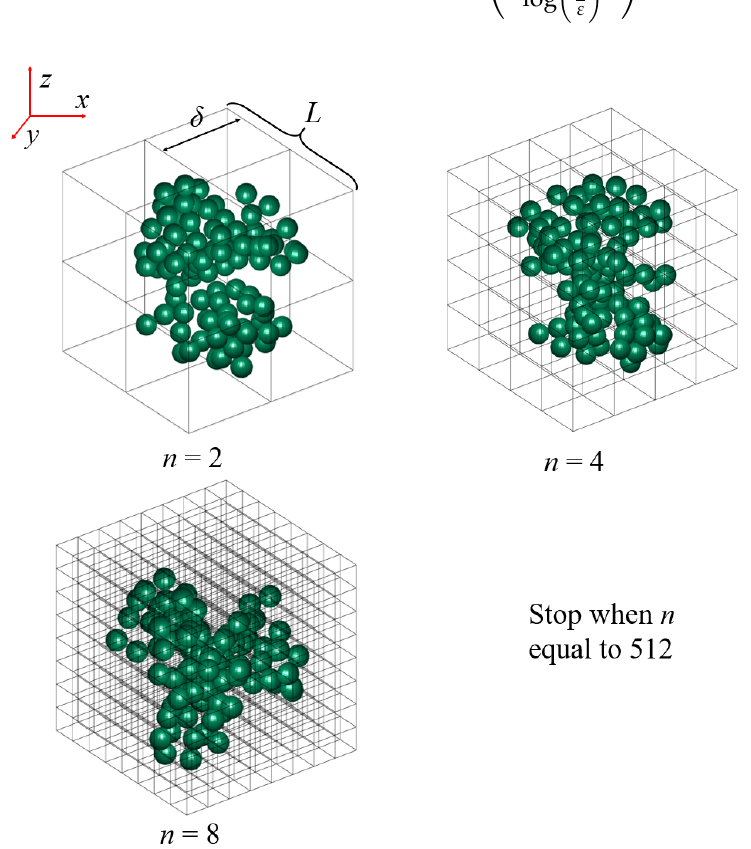
Figure 2. The evolution of n (=1/ ε ) in the 3D box-counting method.